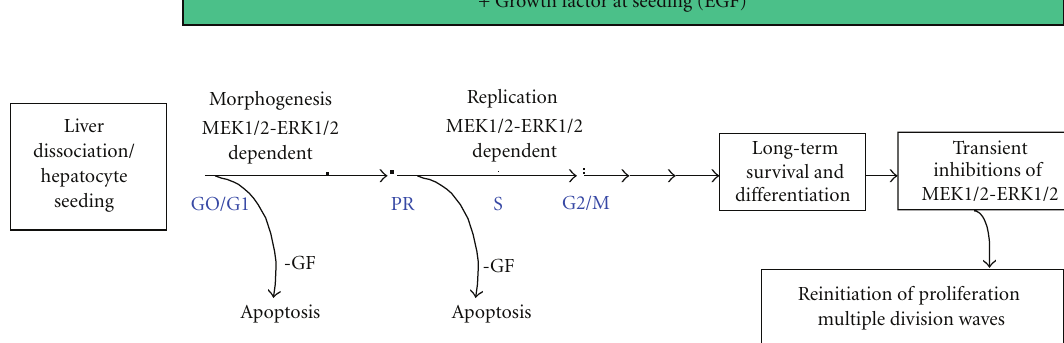
Scheme 2: Long-term survival/di ff erentiation in EGF stimulated cells and sequential MEK/ERK inhibitions allowing multiple divisions waves. Hepatocytes are cultured in presence or absence (-GF) of EGF and after one week of culture, transient inhibitions of MEK/ERK by U0126 allow EGF-cultured hepatocytes to re-enter in new cell